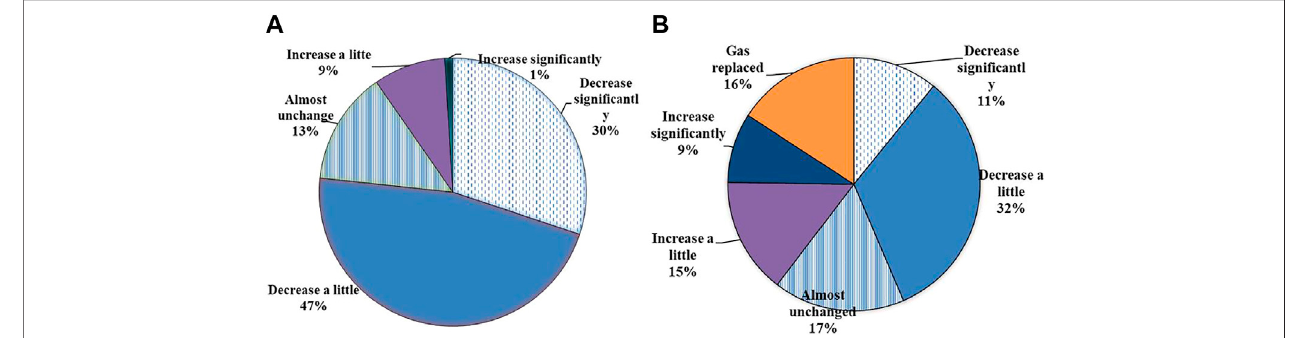
FIGURE 8 | Perspectives on monthly electricity (A) and gas (B) cost change after moving into the district.